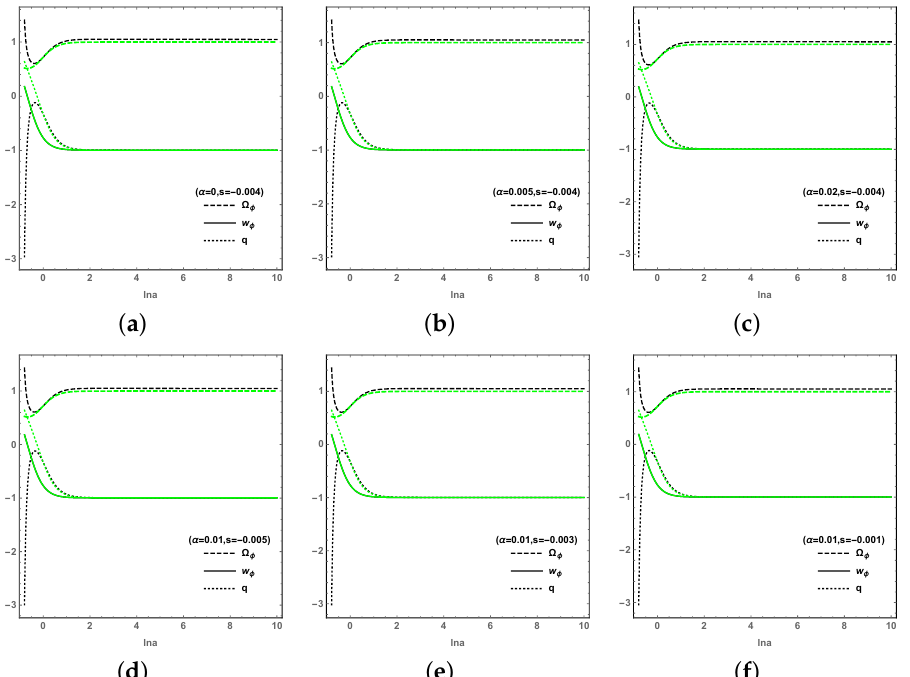
Figure 4. The comparison of the evolutions of Ω φ , w φ and q in EC (green) with the ones in LQC (black) around P 2 by the initial condition x 0 = 0.8, y 0 = 1.5, z 0 = 0.1. ( a – c ) correspond to different coupling parameters α = 0,0.005,0.02 and fixed potential parameter s = − 0.004; alternately, ( d – f ) correspond to different potential parameters s = − 0.005, − 0.003, − 0.001 and fixed coupling parameter α = 0.01.